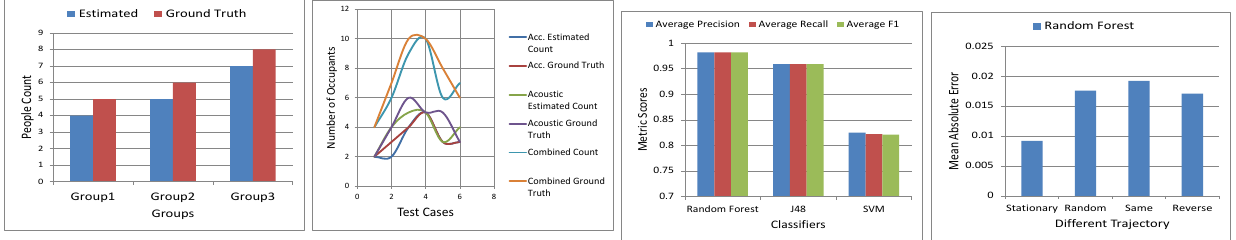
Figure 16: People Counting vs. Multiple Co-located Group